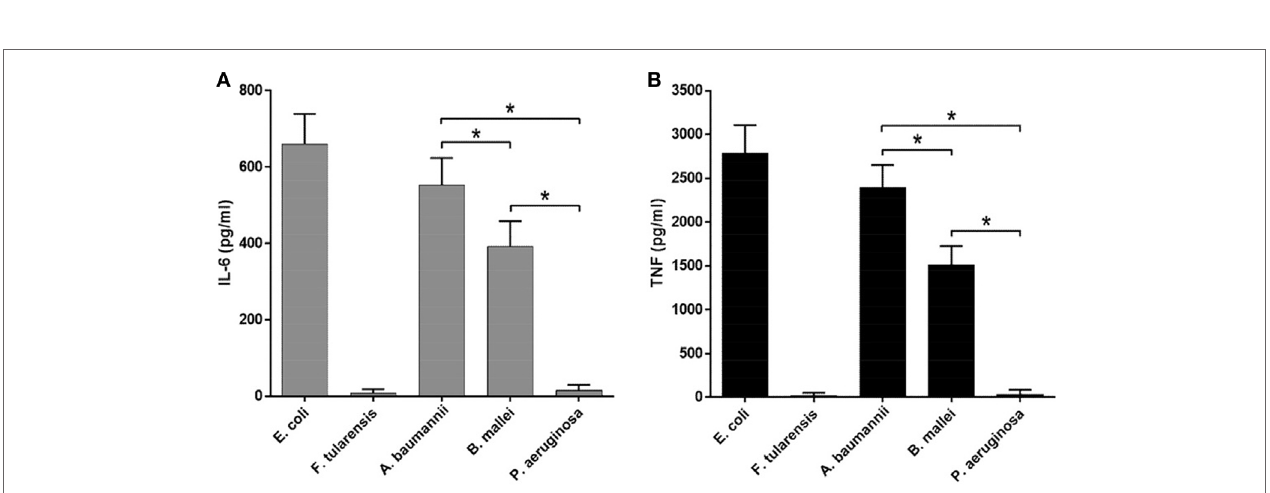
FigUre 5 | expression of proinflammatory cytokines by BMDM upon sactivation by lPs from various bacteria . ELISA quantification of IL-6 (a) and TNF (B) level in the supernatants of LPS-stimulated BMDM of WT mice. All data are representative of three or more independent experiments. Data represent mean values ± SEM. * P < 0.05, as calculated by Student’s t